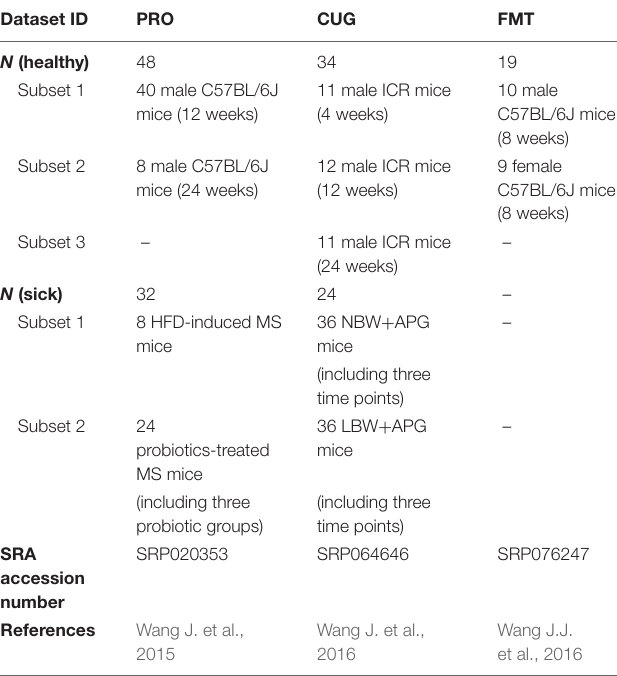
TABLE 1 | The fecal samples of healthy and disease mice from three datasets used in this study. Dataset